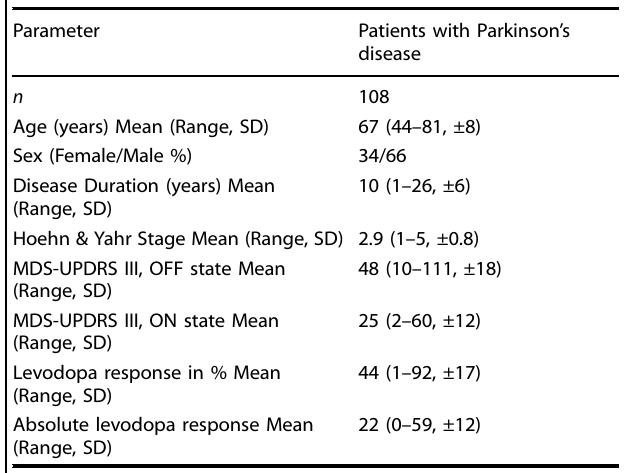
Table 1. Demographics and clinical characteristics of the PD patient group.